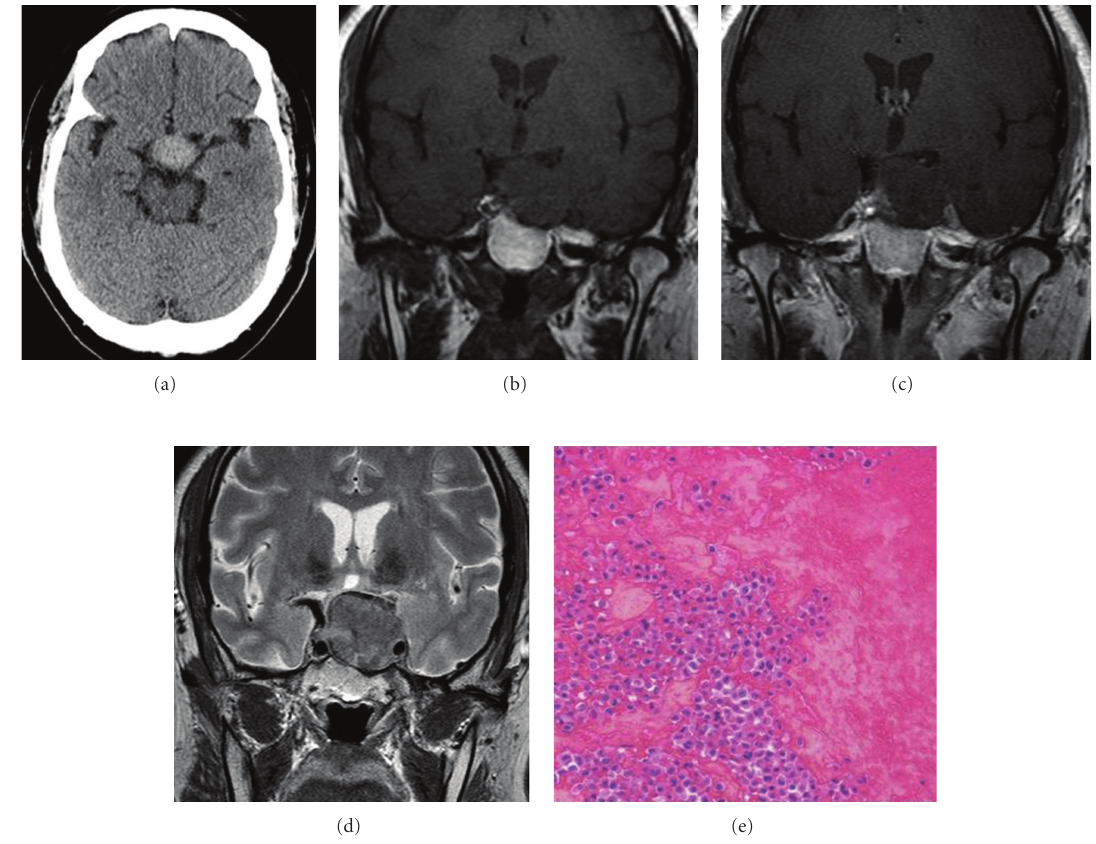
Figure 1: Case 1. CT scan performed 1hr after onset demonstrates intratumoral hemorrhage (a), T1-weighted MRI showing a pituitary tumor extending into the suprasellar cistern (b), after onset gadolinium enhanced coronal T1-weighted MRI showing no enhancement of the pituitary tumor (c), T2-weighted MRI showing a pituitary tumor with a low-signal-intensity rim. This finding was suggestive of pituitary apoplexy (d), Specimen stained with hematoxylin and eosin. Hemorrhage and necrosis on the right side of the picture and area of nonnecrotic papillary-patterned tumor tissue on the left